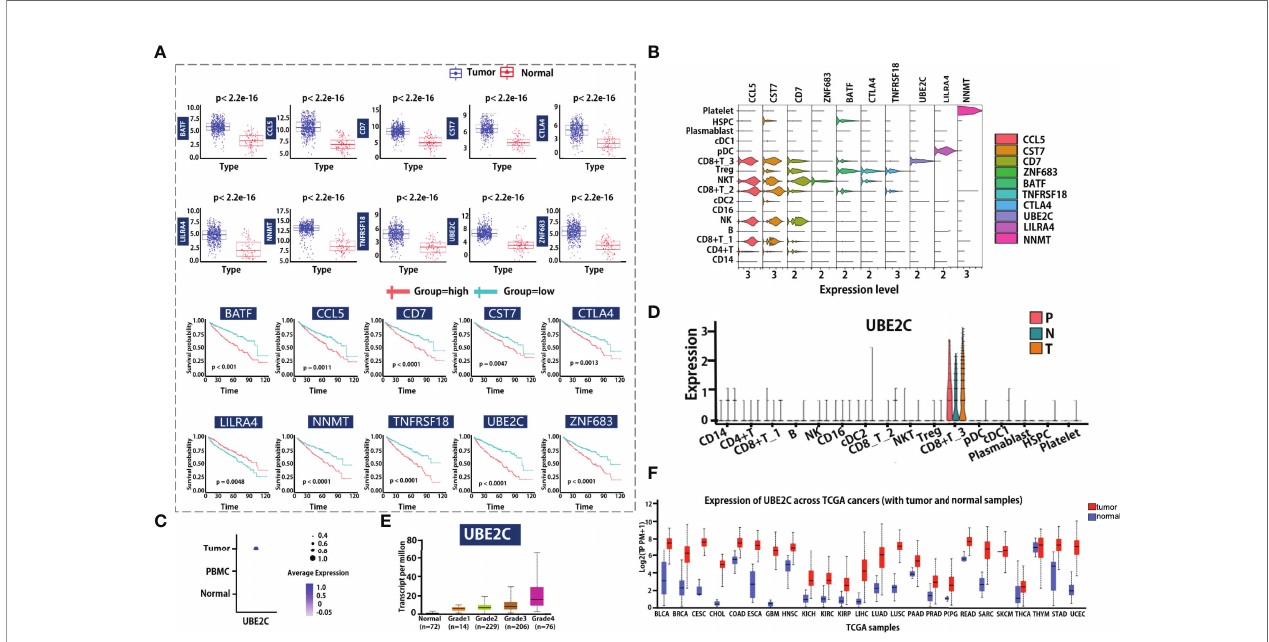
FIGURE 5 | Clinical outcome correlation analysis of cellular composition and gene expression. (A, B) Marker genes identi fi ed by bulk RNA-seq data associated with scRNA-seq data. Boxplot visualized the gene expression level of genes in the tumor or adjacent normal tissue group (A left) . Each dot represents a candidate gene; the blue and red color means tumor or matched adjacent normal tissue group. Survival analysis for candidate markers of each cell type in ccRCC (A) right. The red and light blue lines indicate the groups with high or low gene expression. Violin plot shows the candidate markers ’ expression pro fi le in all major cell types. (C, D) Dot plot shows the UBE2C gene expression level in different tissue types or cell types. N indicates tumor in matched adjacent normal tissue, T means renal tumor tissue, and P represents peripheral blood. (E) Visualization of the association relationship of the expression level of UBE2C with ccRCC tumor grades. (F) Comparing the expression of UBE2C in tumor tissue and adjacent normal tissue across